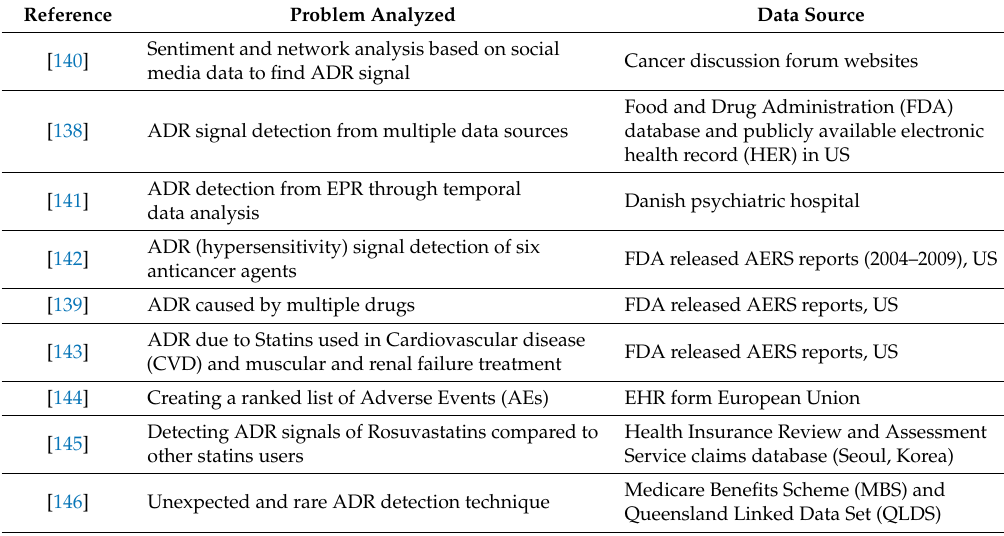
Table 10. List of data mining application in pharmacovigilance with data